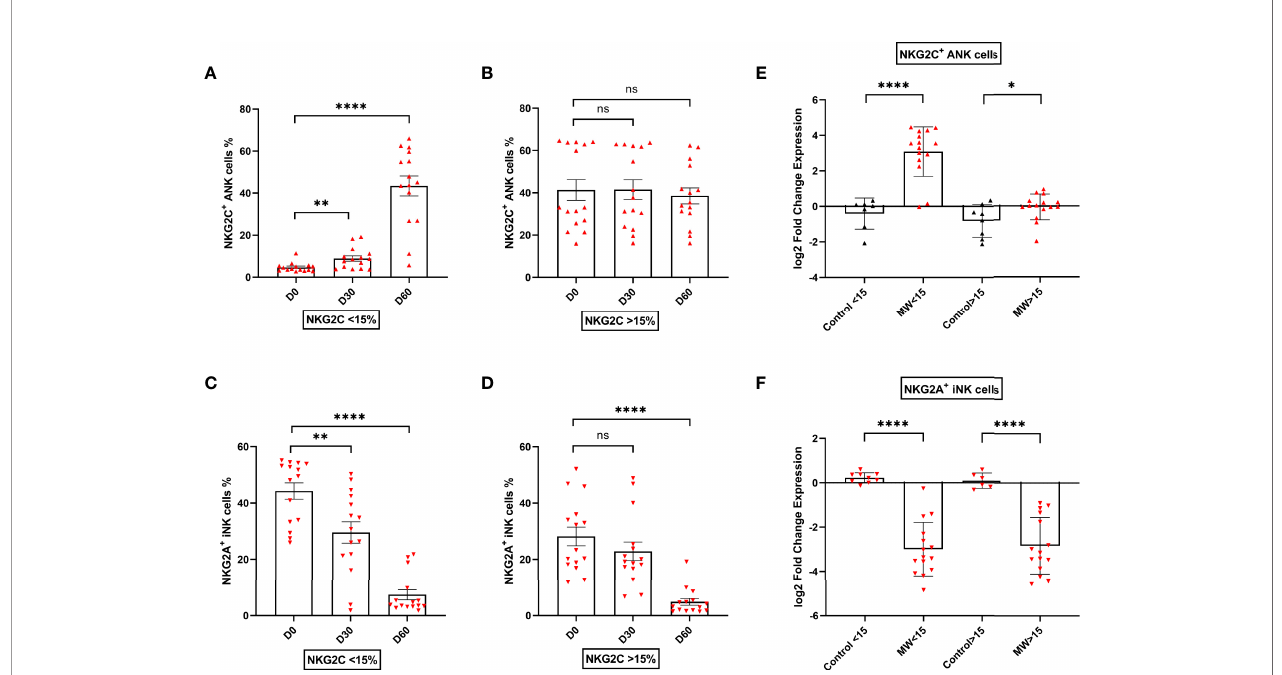
FIGURE 4 | Impact of Mw on upregulation of NKG2C + ANK cells with respect to NKG2C expression at baseline: Scatter dot with bar plot showing the kinetics of (A) NKG2C + ANK cells (n=15) and (C) NKG2A + iNK (n=15) cells expression in Mw group at baseline, days 30 and 60 in respect to <15% NKG2C at baseline. (B) NKG2C + ANK (n=15) cells and (D) NKG2A + iNK (n=15) cell expression in Mw group at baseline, days 30 and 60 in respect to >15% NKG2C at baseline. Log2FC expression of (E) NKG2C + ANK and (F) NKG2A + iNK cells at day 60 after normalization with baseline value in Mw group (>/<15%, n=15) and control group. Red upside and downside shaded triangles represent NKG2C + ANK and NKG2A + iNK respectively for Mw group. Black upside and downside shaded triangles represent NKG2C + ANK and NKG2A + iNK, respectively, for control group. ****p < 0.0001, **p < 0.01, *p < 0.05, and ns, p-value not signi fi